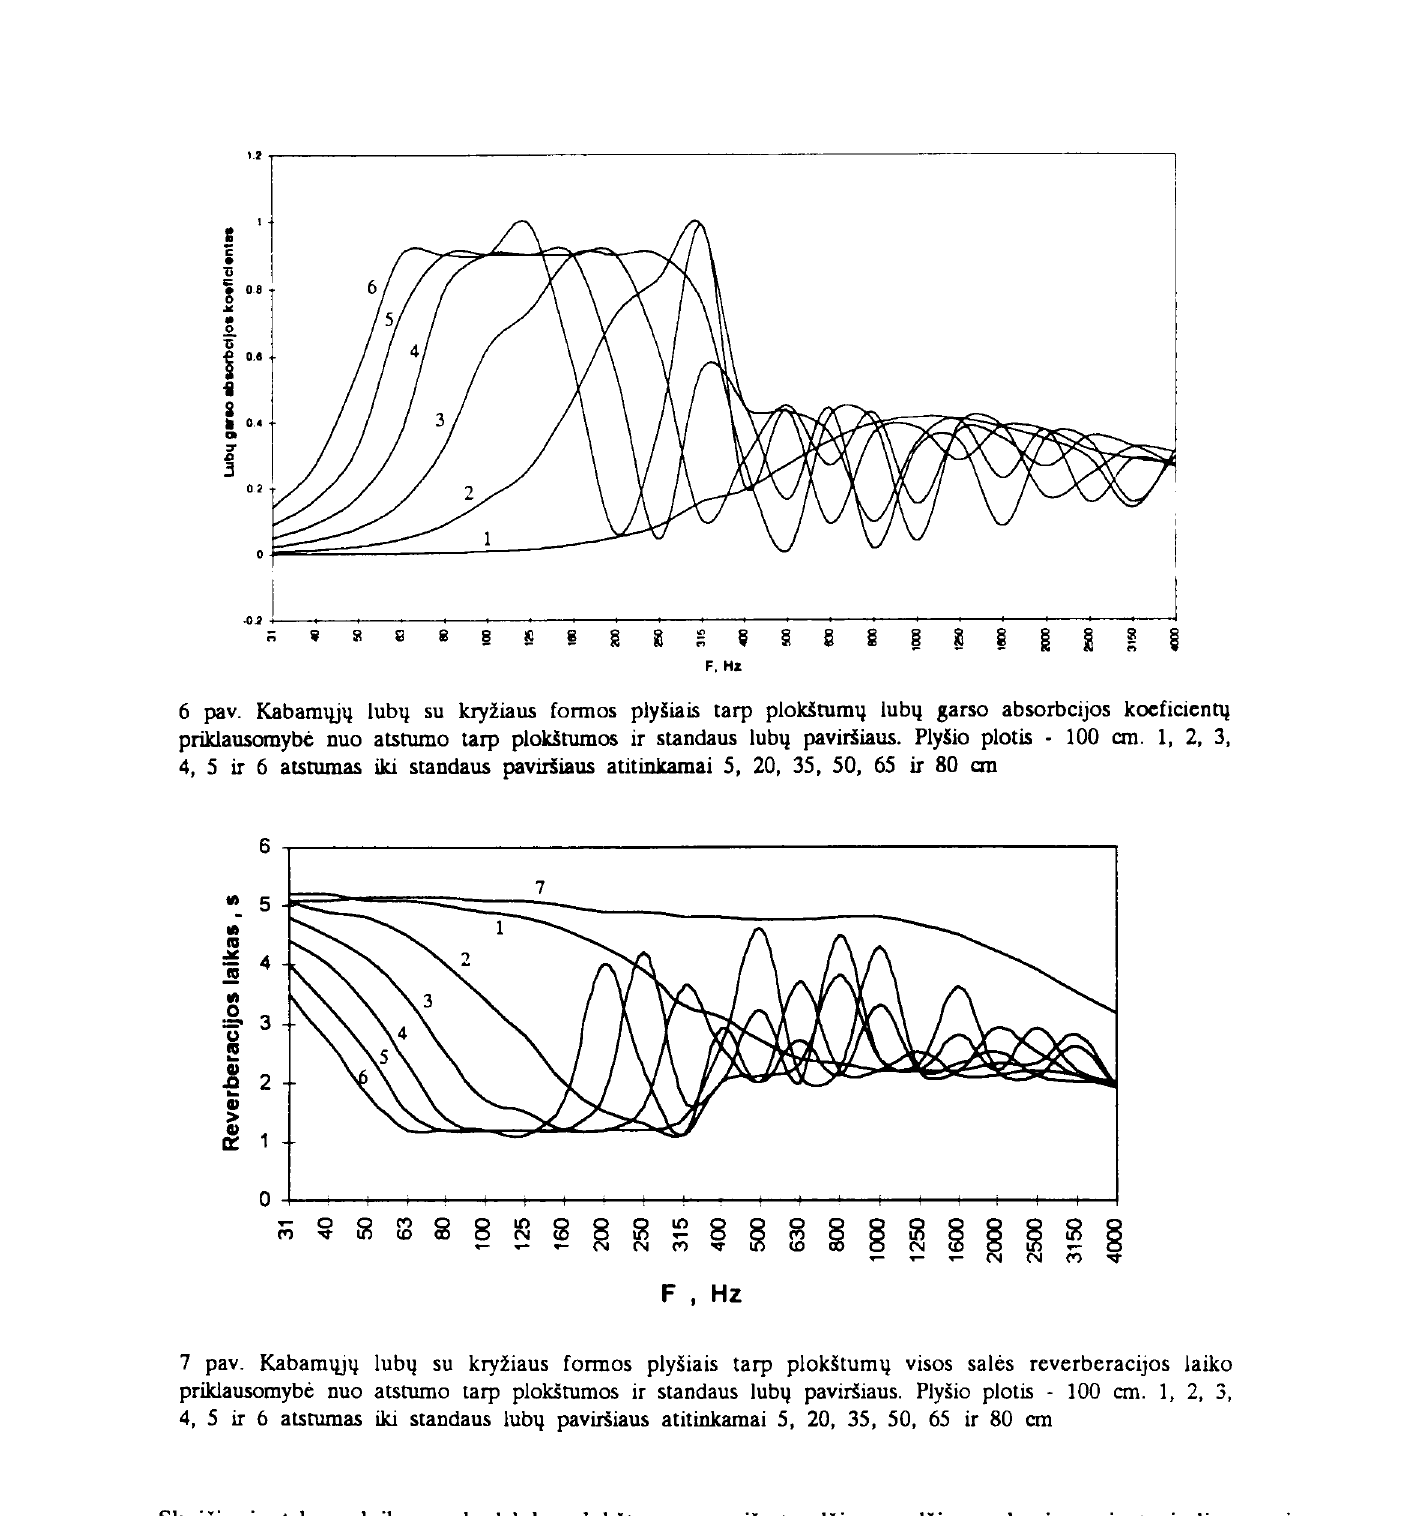
SkaiCiuojant buvo laikoma, kad lub4 plokstumos yra is standiios mediiagos, kuri gerai atspindi gars~t ir blogai jj absorbuoja. Vadinasi pacios lub4 plokstumos garso beveik neabsorbuoja. Taigi, ji absorbuoja tik plysiai tarp si4 plokstum4. Vadinasi, apskaiCiuojant absorbcijos koeficient~t reikia imti nc vis4 lubq plot~t. bet tik plysi4 plot~t. Tada iseina, kad maksimalus plysi4 garso absorbcijos koeficientas yra ne 0,9, bet 2,0. Jo kitimo charakteris yra toks pats, kaip ir vis4 lub4 garso absorbcijos koeficiento. Tai galima paaiskinti tuo, kad rezonanso metu padideja absorbcijos plotas, t.y. rezonatoriaus efektyvumas. Rezonansines kreives ploCiui jtakos turi rezonatoriaus